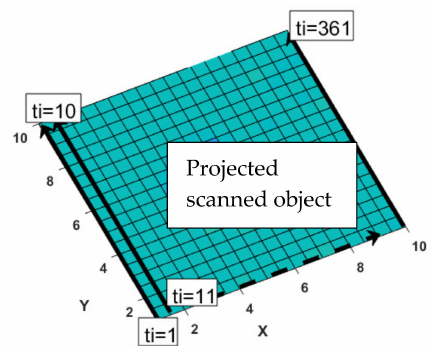
Figure 4. Explanation of the concept of line wise noise. One noise vector is added to each line for a constant x independently. In this example, from t i = 1 to t i = 10 is added one noise vector. A new one is added starting from t i = 11. The same procedure is repeated for as many lines as the point clouds